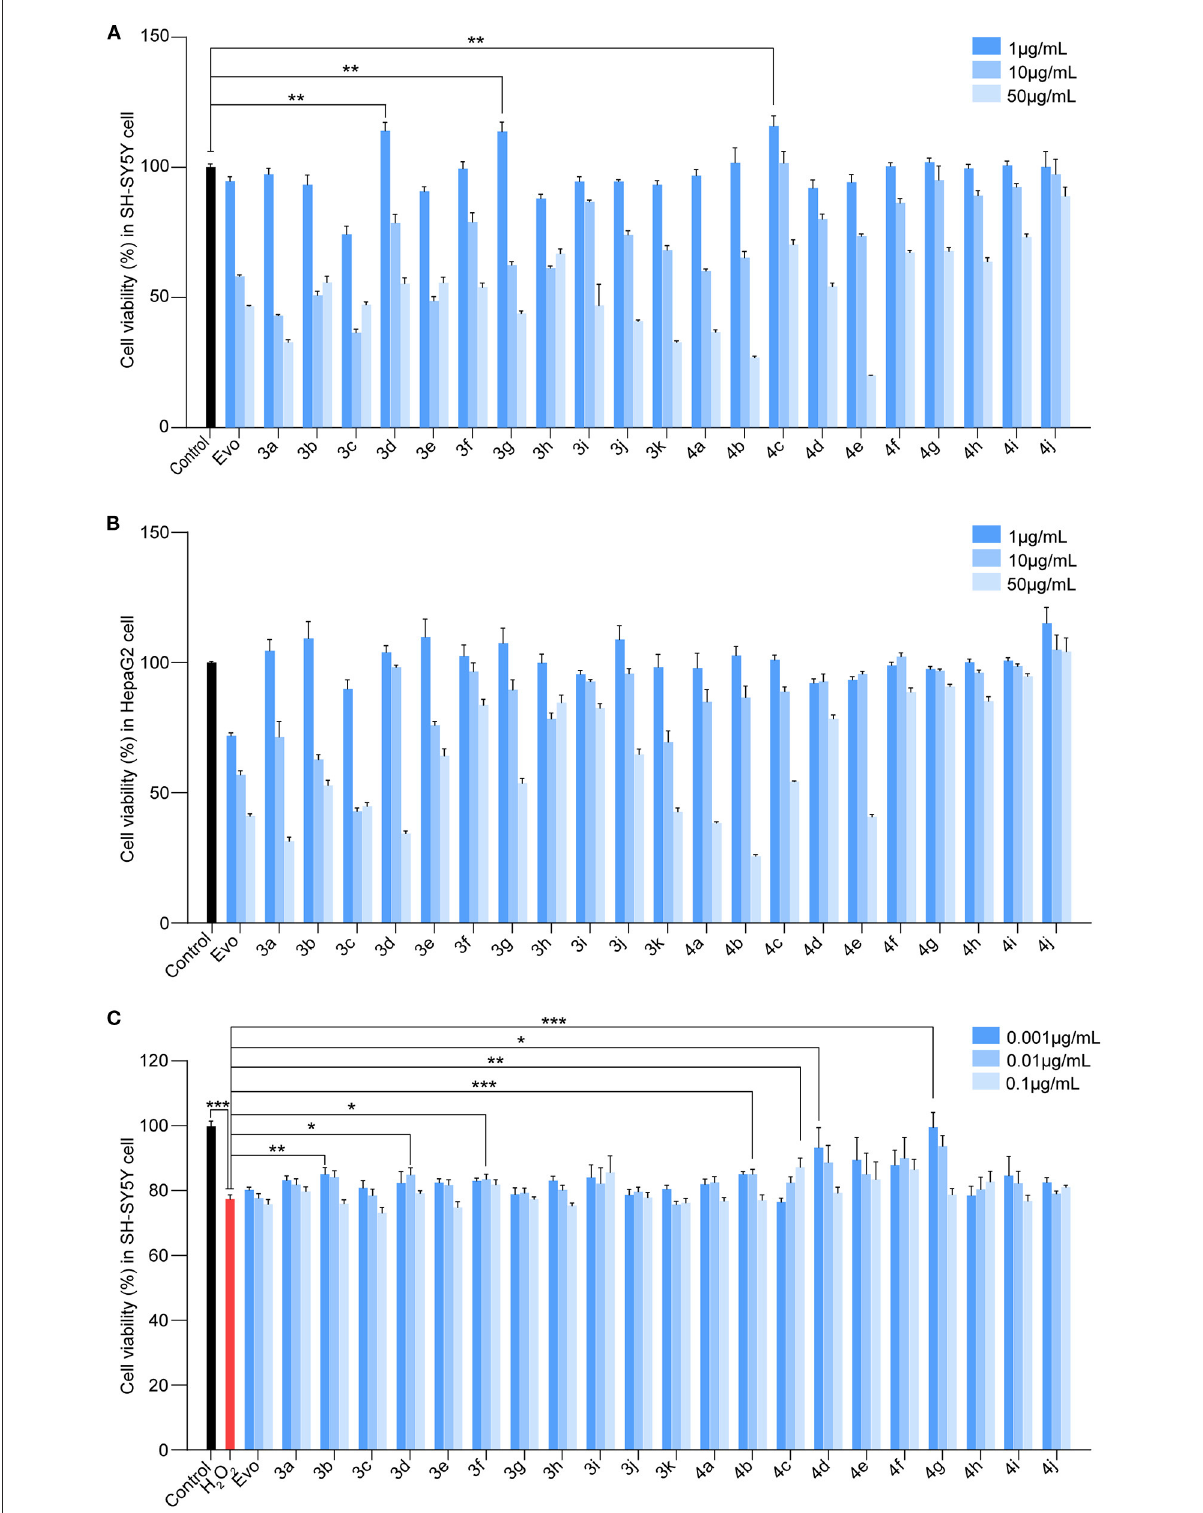
FIGURE2 Screening for the cytotoxicity and the anti-H 2 O 2 activity of the evodiamine derivatives. (A, B) SH-SY5Y cells and HepaG2 cells were treated with Evo and Evo derivatives at concentrations of 1, 10, and 50 µ g/ml for 24h. The cytotoxicity of Evo and its derivatives was subsequently assessed by detecting cell viability using CCK8. (C) SH-SY5Y cells were co-incubated with 75 µ M H 2 O 2 and different concentrations of Evo derivatives (10 − 3 , 10 − 2 , and 10 − 1 µ g/ml) for 24h, and cell viability was quantified using CCK8. Data are represented as mean ± SEM, n = 6; * P < 0.05, ** P < 0.01, and *** P < 0.001 vs.